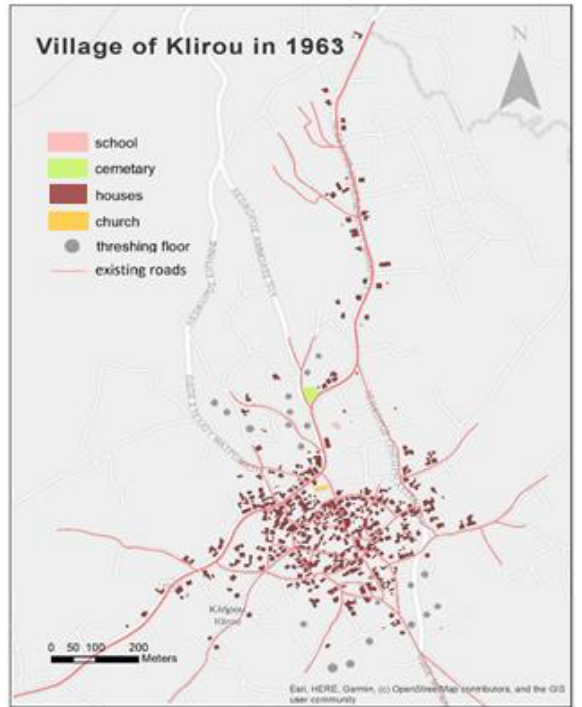
Figure 5. Map of the village of Klirou produced in a GIS environment through photo interpretation of aerial imagery taken in